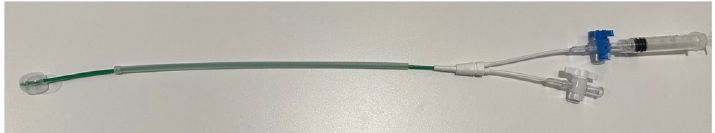
Fig. 4 HSG catheter with balloon inflated. This catheter is 5.5 French. The plastic stiffener which helps stabilize it the catheter at the cervical os can be advanced into the cervix and the HSG catheter exchanged for a 5 French Kumpe catheter for selective salpingography and FTR. There are many types of HSG catheters on the market including some which are 9 French and have a lumen which will accommodate catheters up to 6.0 French